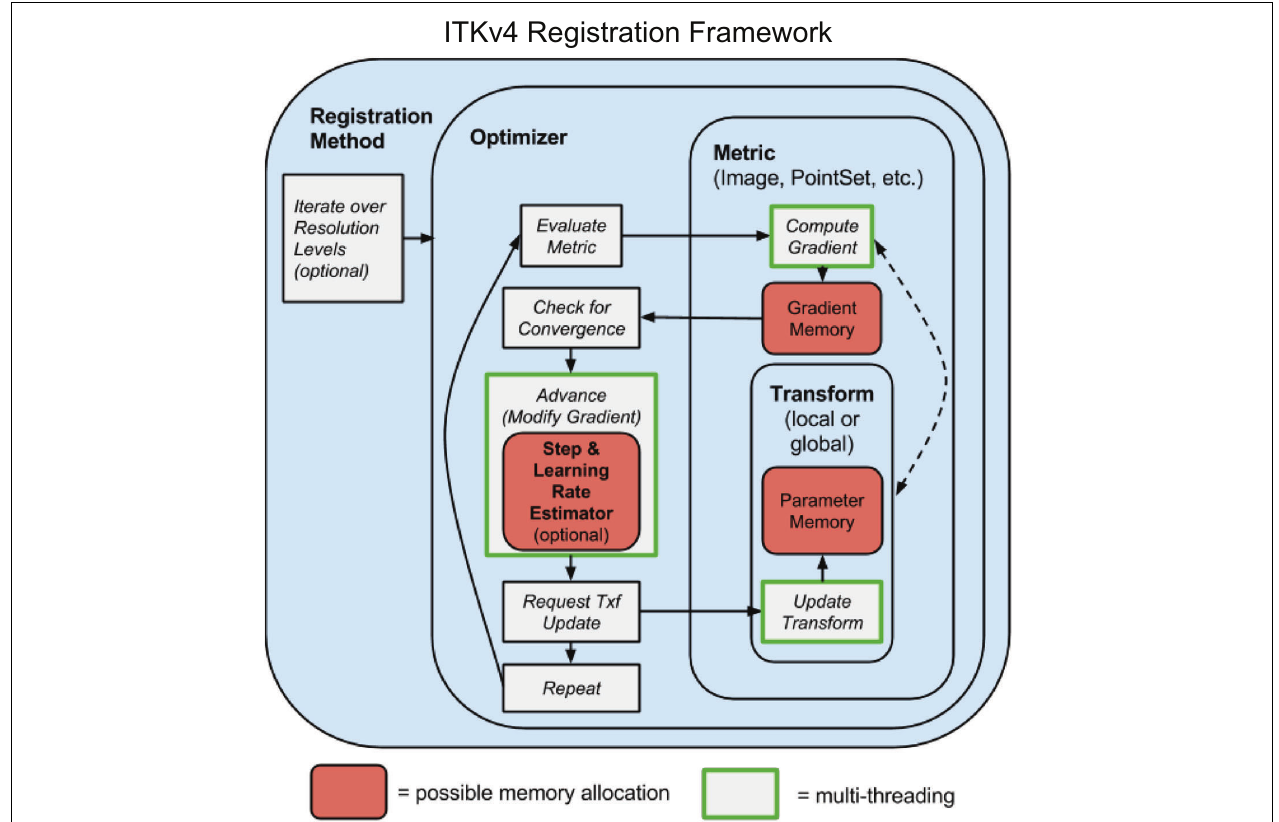
FIGURE 1 | A schematic overview of the prototypical ITK 4 registration method. This design is overall similar to that of ITK 3 . A few key components differ:(1)optimizersrequirethattransformsupdatethemselves;(2)metricsand optimizersaremulti-threaded;(3)memoryissharedacrossbothoptimizersand